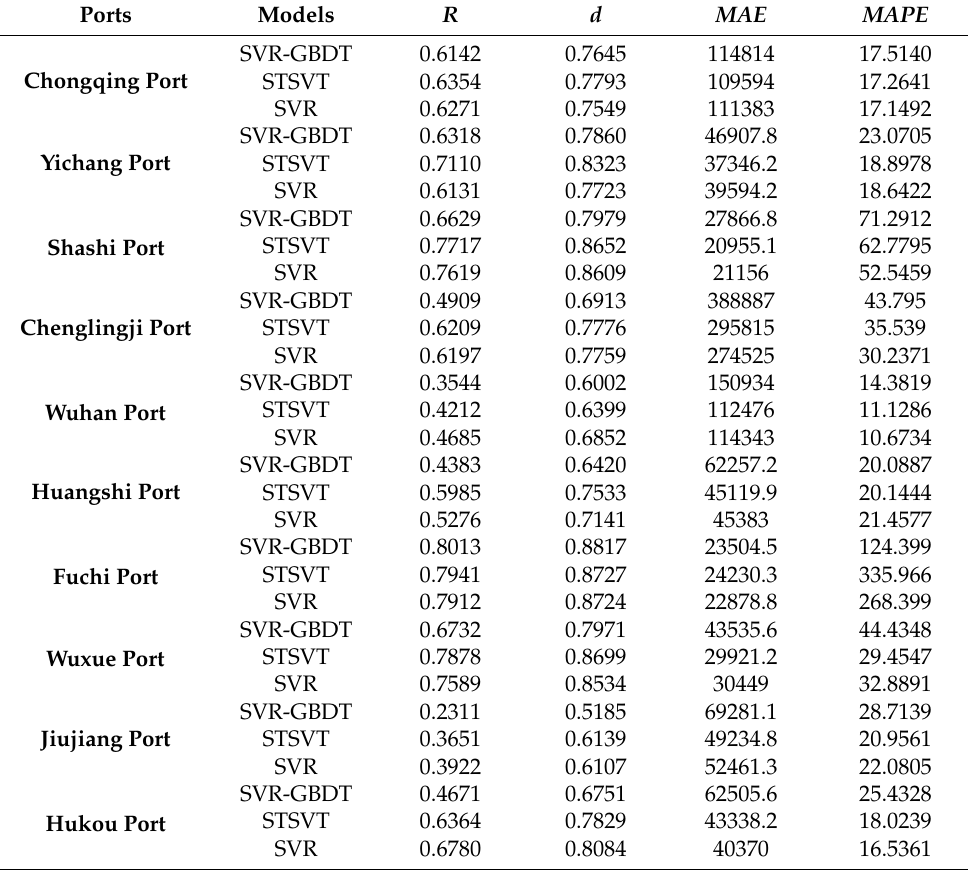
Table 4. Evaluation results of predictions based on SVR, SVR-GBDT, and STSVR.